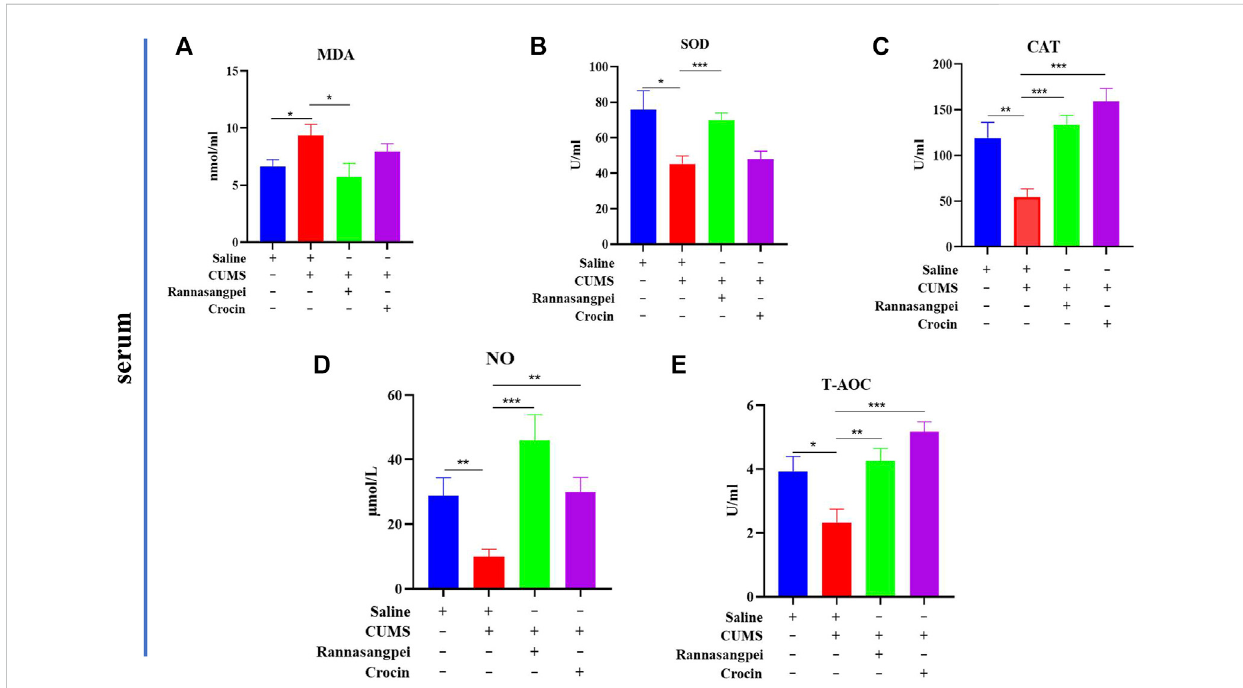
FIGURE 2 RSNP and crocin-1 restored oxidative stress marker levels in serum of CUMS-treated mice (A) The CUMS-treated mice exhibited elevated serum MDA levels, whereas RSNP, but not crocin-1 administration signi fi cantly reduced MDA levels in the CUMS-treated mice. (B) The decreased SOD activity found in the CUMS-treated mice was restored by RSNP, but not crocin-1 administration. RSNP and crocin-1 signi fi cantly increased CAT (C) , NO (D) and T-AOC (E) activities or levels in the CUMS-treated mice. SOD, superoxide dismutase; MDA, malondialdehyde; CAT, catalase; NO, nitric oxide; T-AOC,totalantioxidantcapacity;RSNP,rannasangpei;CUMS,chronicunpredictablemildstress.N=8.ForANOVAstatistics: (A) ,F (3,32) =3.45, p =0.032; (B) , F (3,32) = 5.723, p = 0.0031; (C) , F (3,32) = 11.47, p < 0.001; (D) , F (3,32) = 5.136, p = 0.0057; (E) , F (3,32) = 8.867, p < 0.001. * p < 0.05, ** p < 0.01, *** p <